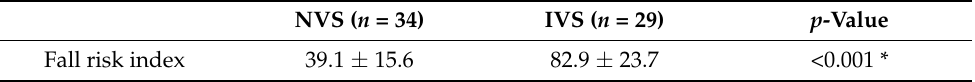
Table 2. Postural steadiness in patients with DM with NVS vs. IVS according to VPT value.